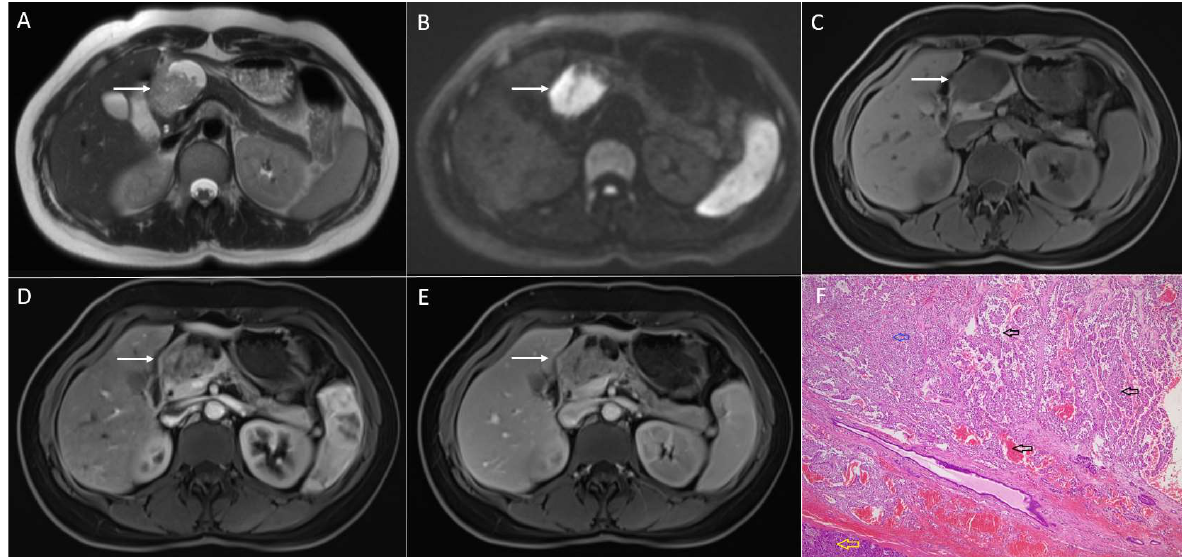
Figure 1. Solid pseudopapillary neoplasm of the pancreas in 25-year-old woman. On axial T2- weighted image ( A ), a mixed solid and cystic tumor ( arrow ) located in the pancreatic head is seen. The solid part of the lesion has high signal intensity on DWI ( arrow ) ( B ), intermediate signal intensity on T1-weighted image ( C ), with heterogeneous enhancement in arterial phase ( D ) and progressive enhancement in portal-venous phase ( E ). Hematoxylin and eosin (H&E) staining ( F ) showed pseu- dopapillary structures ( black arrows ), solid part of the tumor ( blue arrow ), and normal pancreatic parenchyma next to the tumor ( yellow arrow ); original magnification ×400.